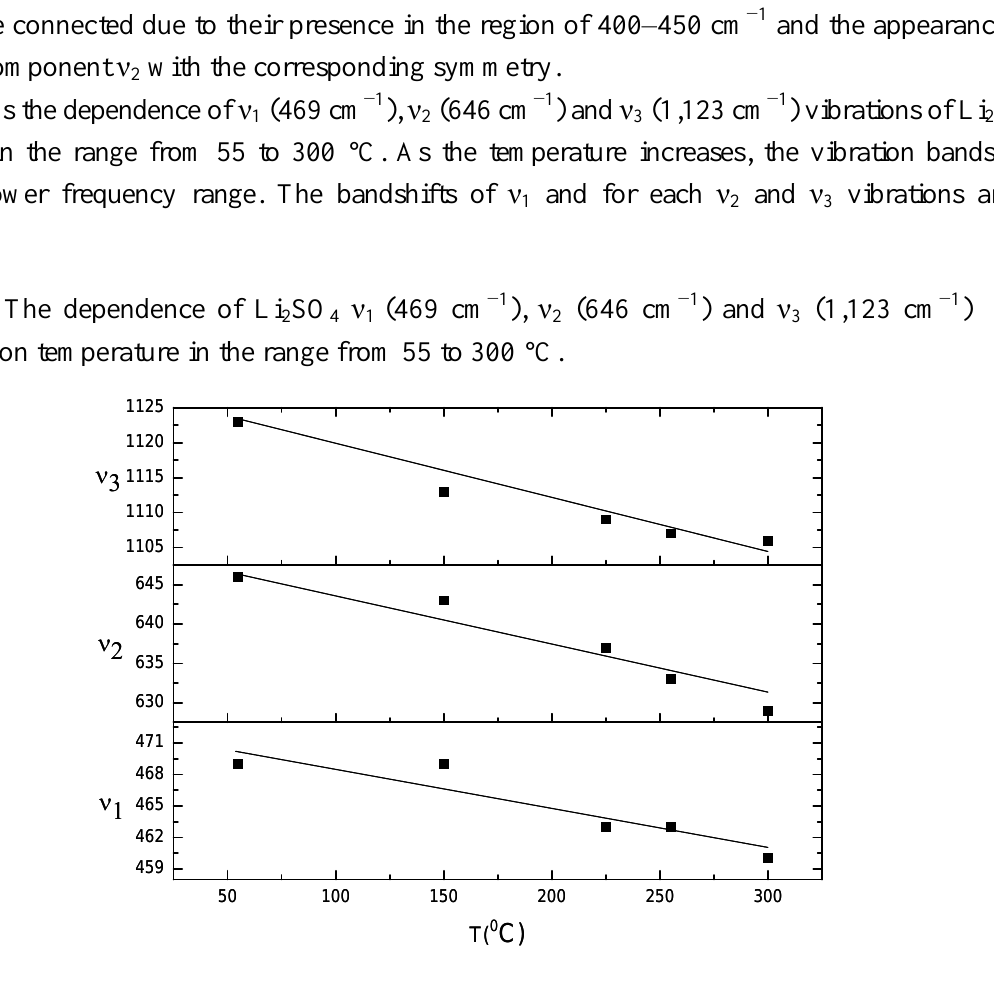
SO ν (469 cm −1 ), ν 2 4 1